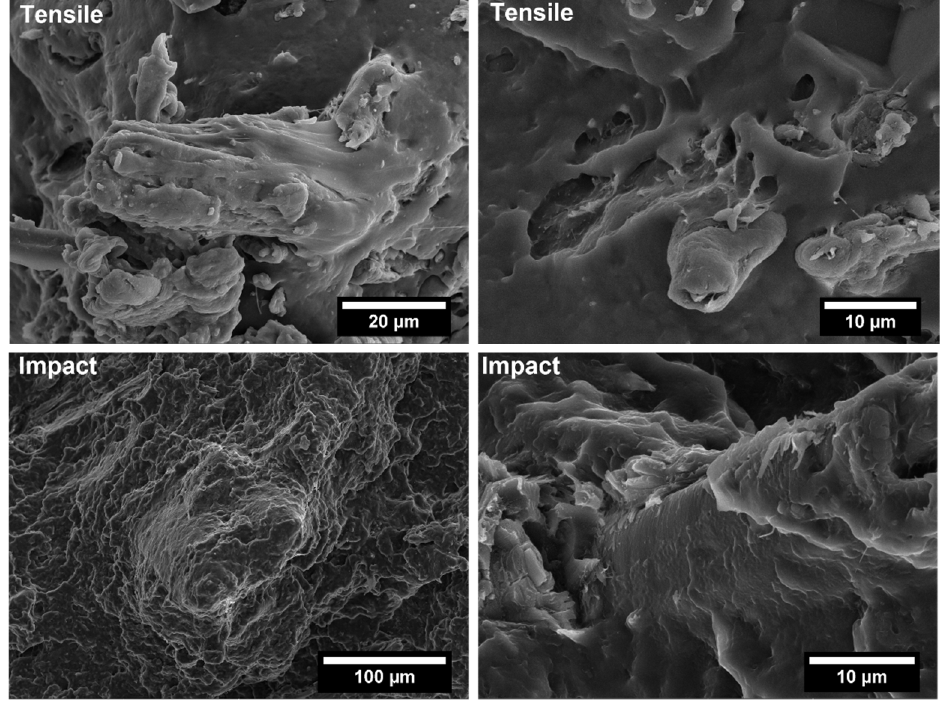
Figure 10. SEM micrographs of PP-based biocomposites with 30 wt.% of holm oak fillers with coupling agent after tensile and Charpy impact tests.